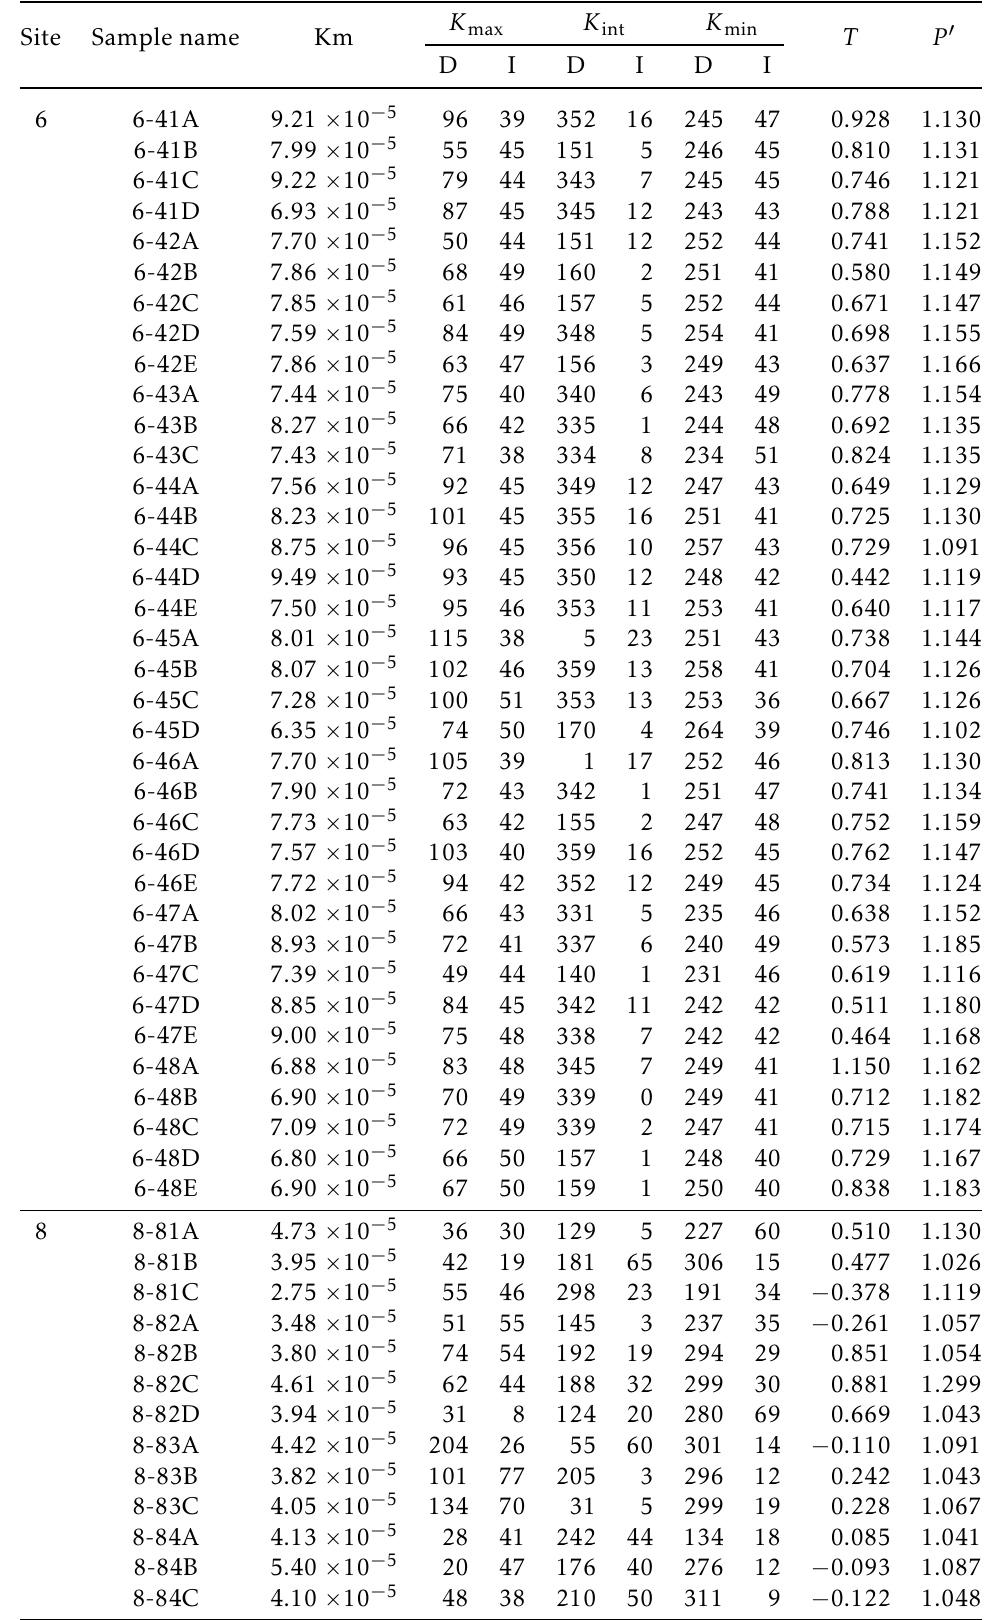
Table A1 [cont.]: Values (Km, in SI) and Directions (D = Declination, I = Inclination, in degrees °) of the principal , K , and K ) of samples from Shiroyama lava; T : shape parameter ( T > 0 oblate, T < 0 susceptibilities ( K max int min : degree of prolate); P 1